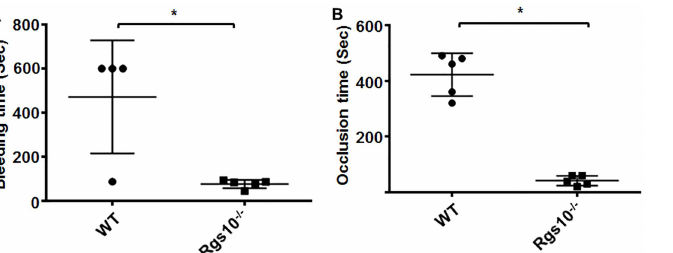
Fig 6. Deletion of RGS10 protein alters physiological hemostasis and development of thrombosis. (A) Bleedingtimes were measured in Rgs10 -/- (n = 5) or WT (n = 4) mice followingvenisection, as described in the “Methods” section. Each point representsthe bleedingtime of a single animal (P < 0.03 Mann-Whitney test). (B) Thrombosis was inducedin Rgs10 -/- (n = 5) and WT (n = 5) mice using chemicalinjury (FeCl 3 ), as describedin the “Methods” section. Each point represents an occlusion time of a single animal (; P < 0.0079 Mann-Whitney